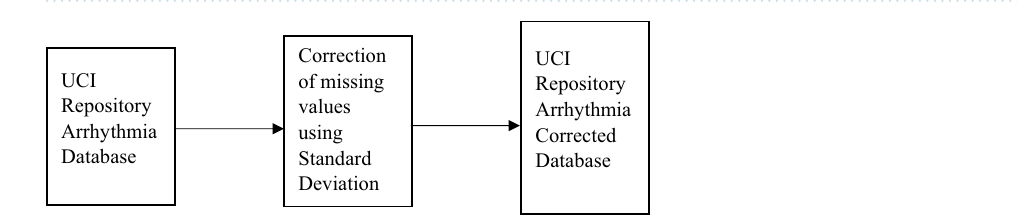
Figure 8. Missing attributes corrected in UCI repository arrhythmia